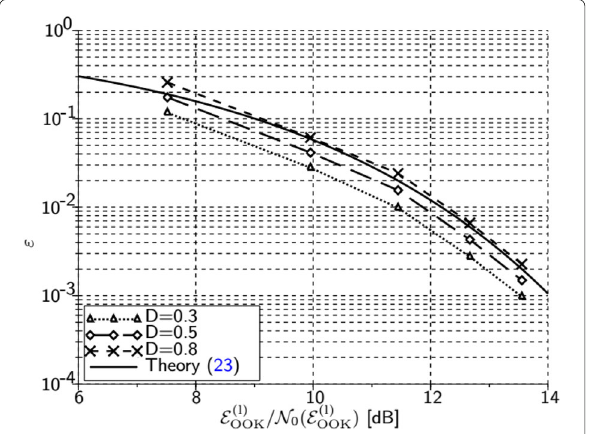
Fig. 6 Decision error performance of the AP ( f 0 = 1 kHz, L = 40 dB HL, ε FA = ε MD